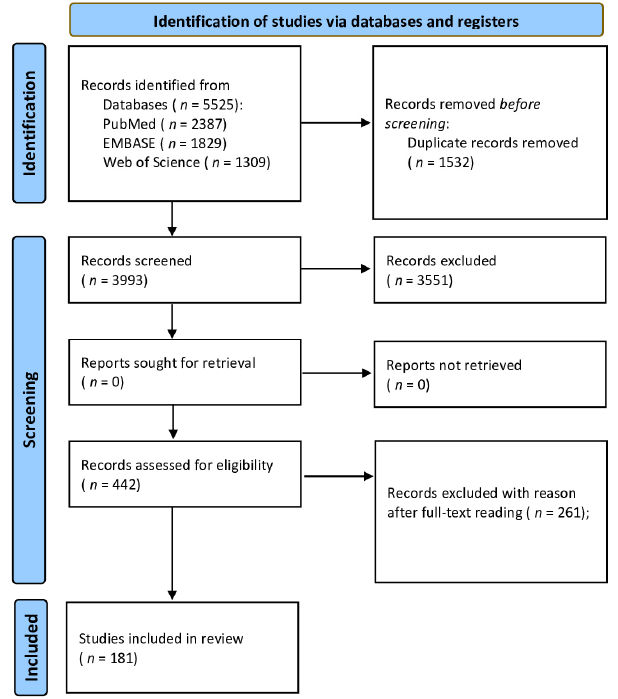
Figure 1. PRISMA flow diagram for systematic review.